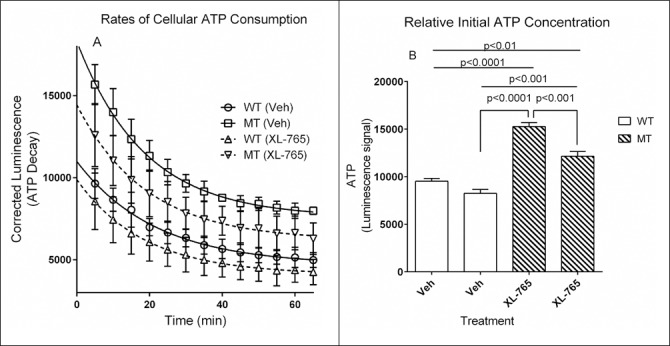
Relative ATP consumption rates and initial ATP concentration in NSCs.ATP concentrations were detected with an ATP-sensitive luminescent probe and monitored for 65 minutes to evaluate the rate of ATP consumption (A; indicating relative concentrations at that time point). Initial relative ATP concentration (B) between genotype and treatment. Data represents the mean of 3 replicates and error bars represent SD. XL-765 was employed at 10 nM in vehicle (Veh; 0.01% DMSO) for 24 h. Data in Fig 4A were analyzed using two-way ANOVA for half-life, as well as effects of time and treatment/genotype. This revealed interaction (half-lives;t1/2 in min.) for ATP consumption that were not significantly different between mutant (starvation conditions, 58.6 [50.6–69.5] and XL-765, 56.0 [44.4–75.7]) and wild-type (starvation conditions, 56.0 [48.9–65.2] and XL-765, 58.6 [48.1–75.0]) following 24 hr of growth/treatment (F (36, 104) = 0.8699; p = ns). Conversely, effects of time and treatment/genotype were significant (time, F (12, 104) = 41.85, p<0.0001; treatment/genotype, F (3, 104) = 177.4; p<0.0001). Data for Fig 5B was evaluated with a one-way ANOVA and post hoc analysis (F (3, 12) = 56.19; p<0.0001. Abbreviations employed were as in Figs 3 and 4.